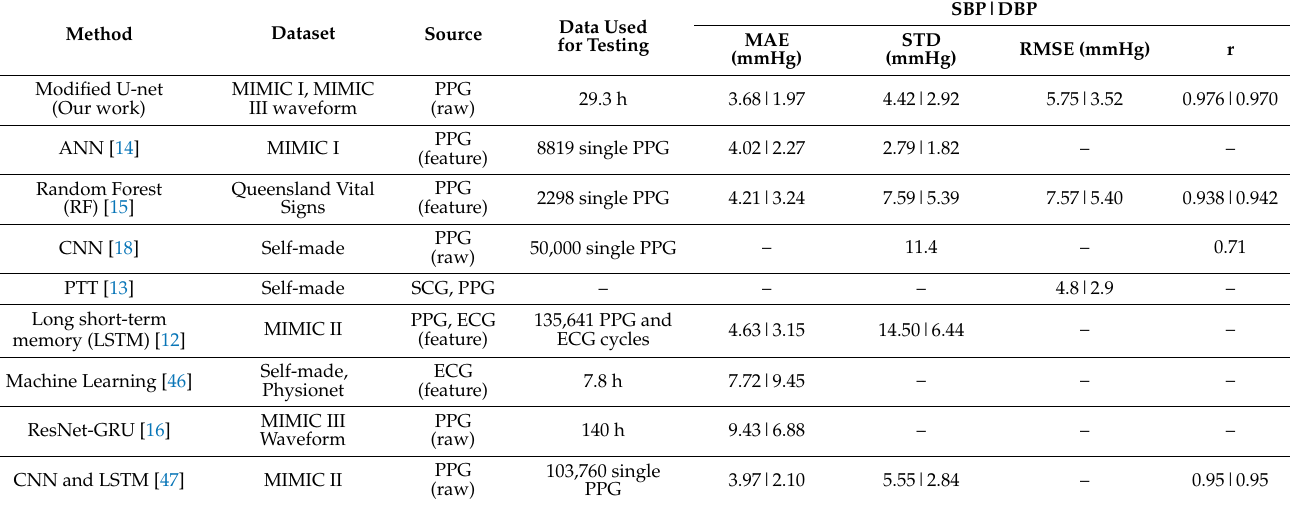
Table 5. Result comparison with related